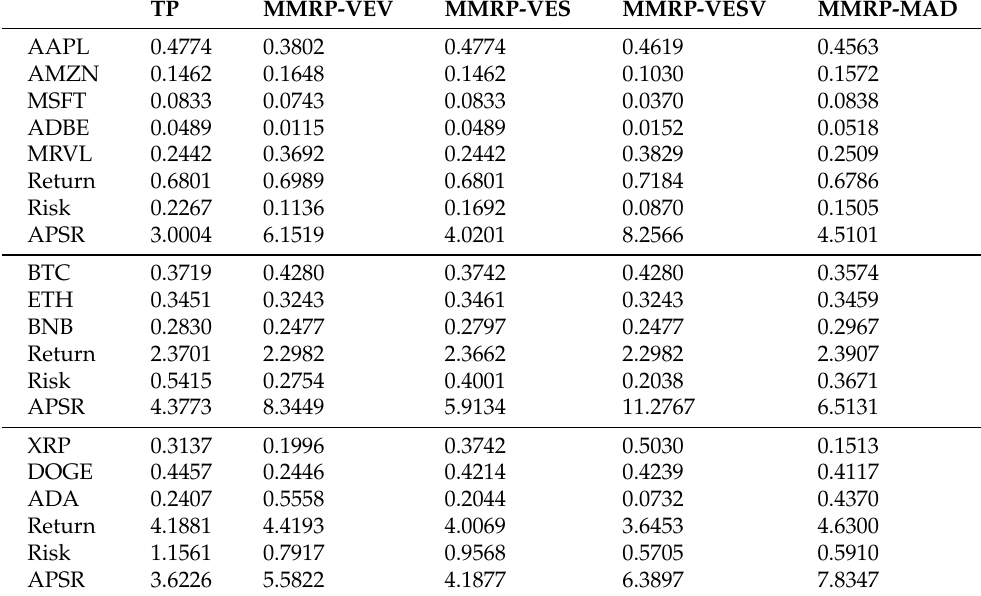
Table 3. Maximum mean-risk portfolios of Stocks and